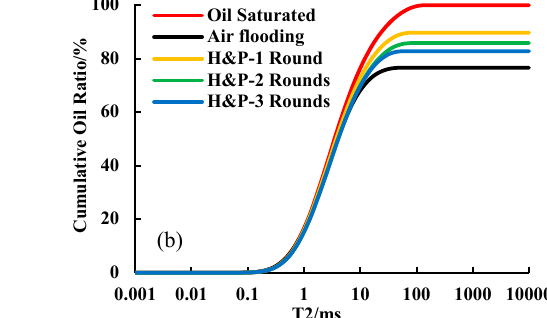
Figure 8. T 2 spectrum of Core J1 before and after air injection ( a ) and the cumulative oil volume proportion ( b ).